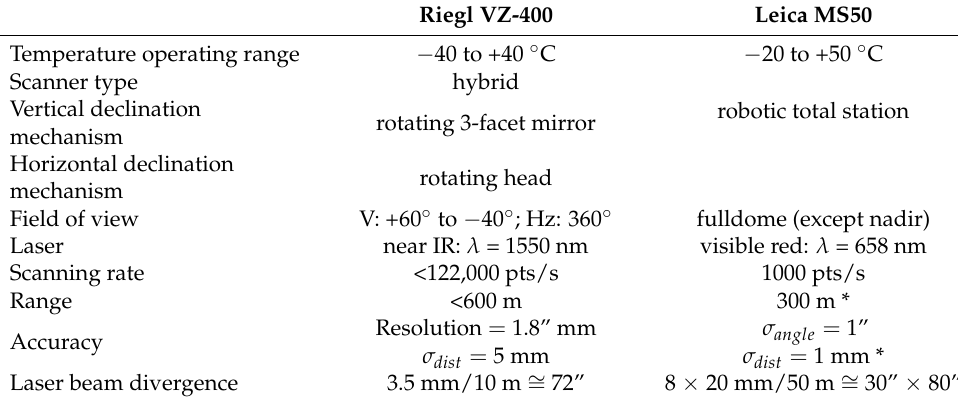
Table 1. Technical specifications of the instruments used in this